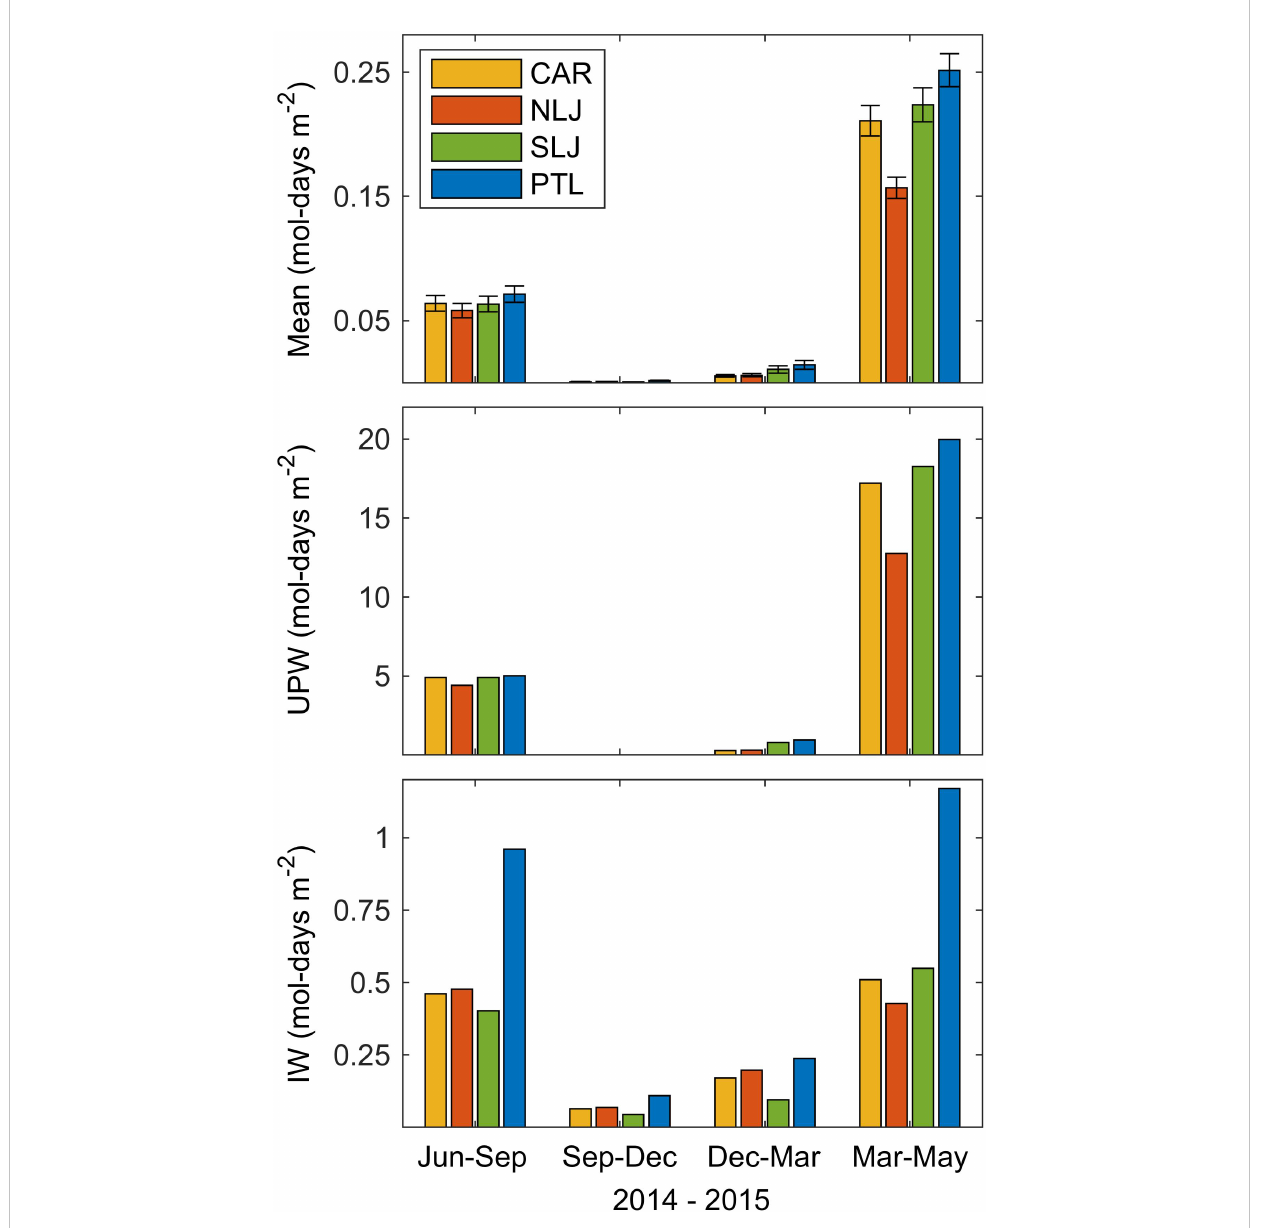
FIGURE 7 Quarterly estimated total nitrate exposure, (NO 3- mol-days m -2 ) for each of the study sites for period 24 Jun 2014 through 25 May 2015. Top panel shows quarterly means and standard error of the total NO 3- exposure. Middle panel show totals for the low-frequency component of exposure corresponding to seasonal upwelling, UPW, ( ƒ < 1 cycle 30 hr -1 ). Lower panel shows totals for the high-frequency component of exposure dominated by diurnal and semidiurnal internal waves, IW, ( ƒ >= 1 cycle 30 hr -1 ). Note differences in y-axis scaling among panels. Sites indicated by color legend in top